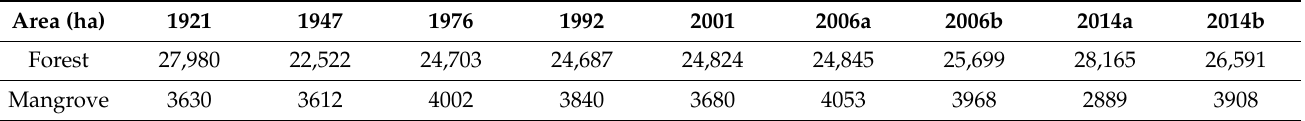
Table 3. Area (hectares) and percentage of island area by vegetation cover class and year for aerial photo and satellite image mosaics of Babeldaob Island, Palau. Here, 2006a and 2014a are pixel-based classifications, 2006-b refers to a manual classification, and 2014-b refers to the USFS polygon based thematic map [25,31] (Iida et al., 2015, USDA 2020). NFV = non-forest vegetation, NV = non-vegetation, and NV in 1921 refers only to